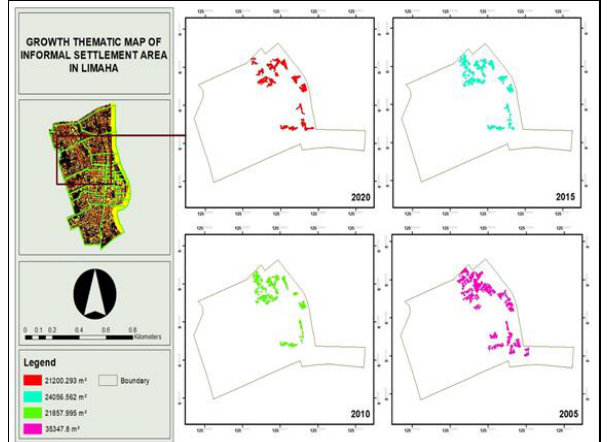
Figure 11. Thematic Map of Brgy. Limaha from 2005-